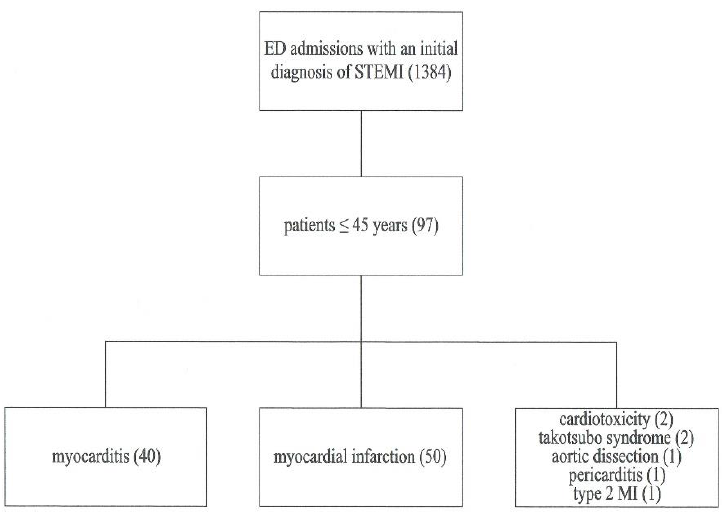
Figure 1. Study flow chart, MI—Myocardial